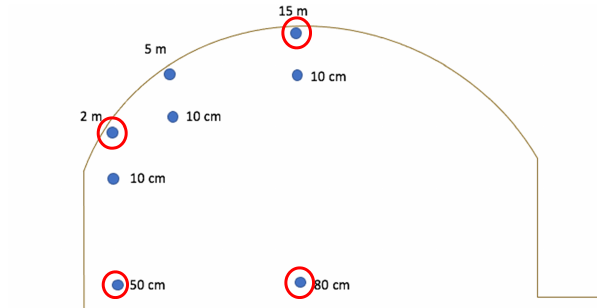
Figure 3. Sampling locations (2, 5, and 15m from ditches) and depths (cm) from the 1987, 2007, and 2016 sectors. Those with red circles were also sampled for 14 C dating at the 2007 and 2016 sec- tors. Horizontal lines indicate approximate ditch surface with peat extending below these